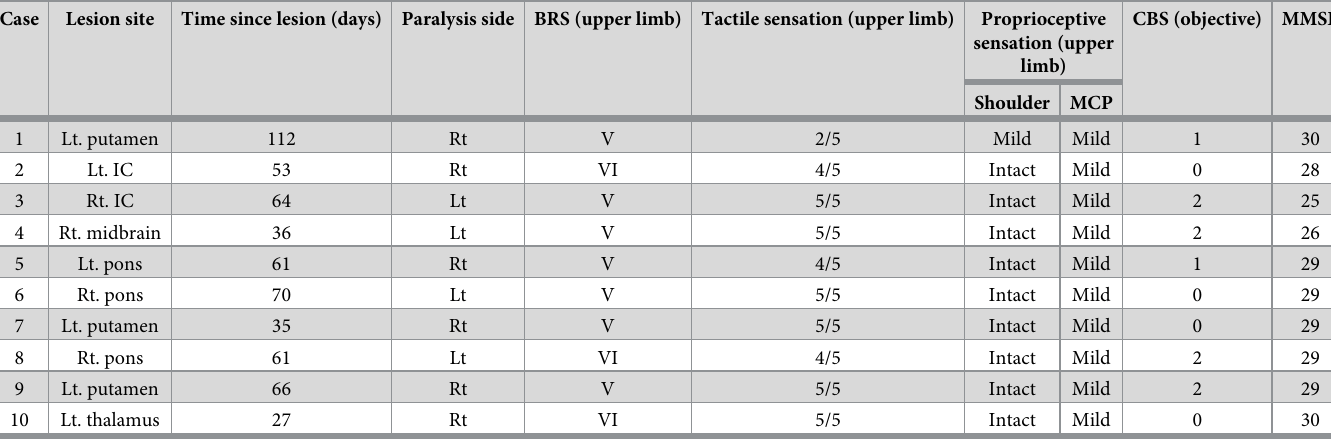
Table 1. Summary of patients’ clinical